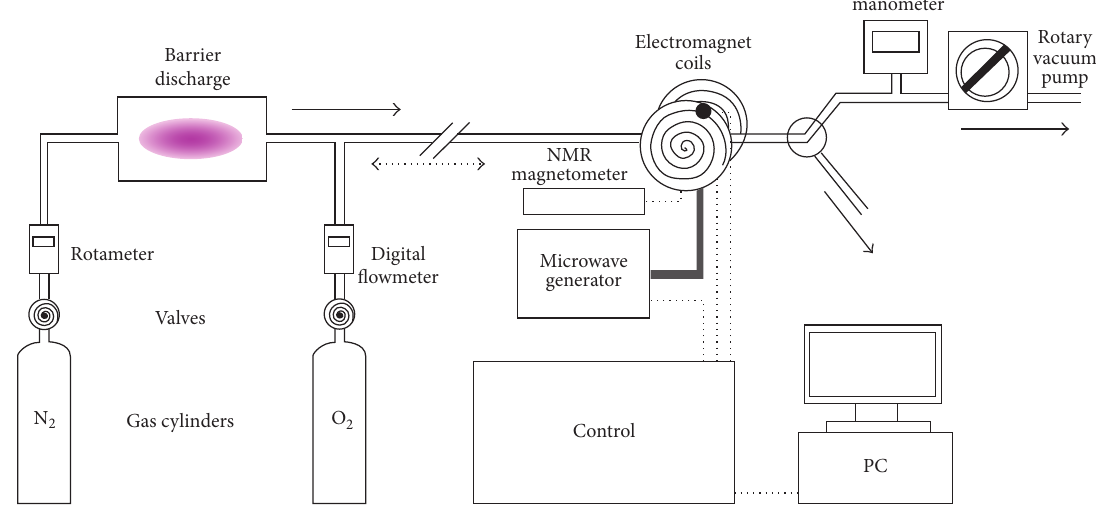
Figure 1: Schematic drawing of the experimental